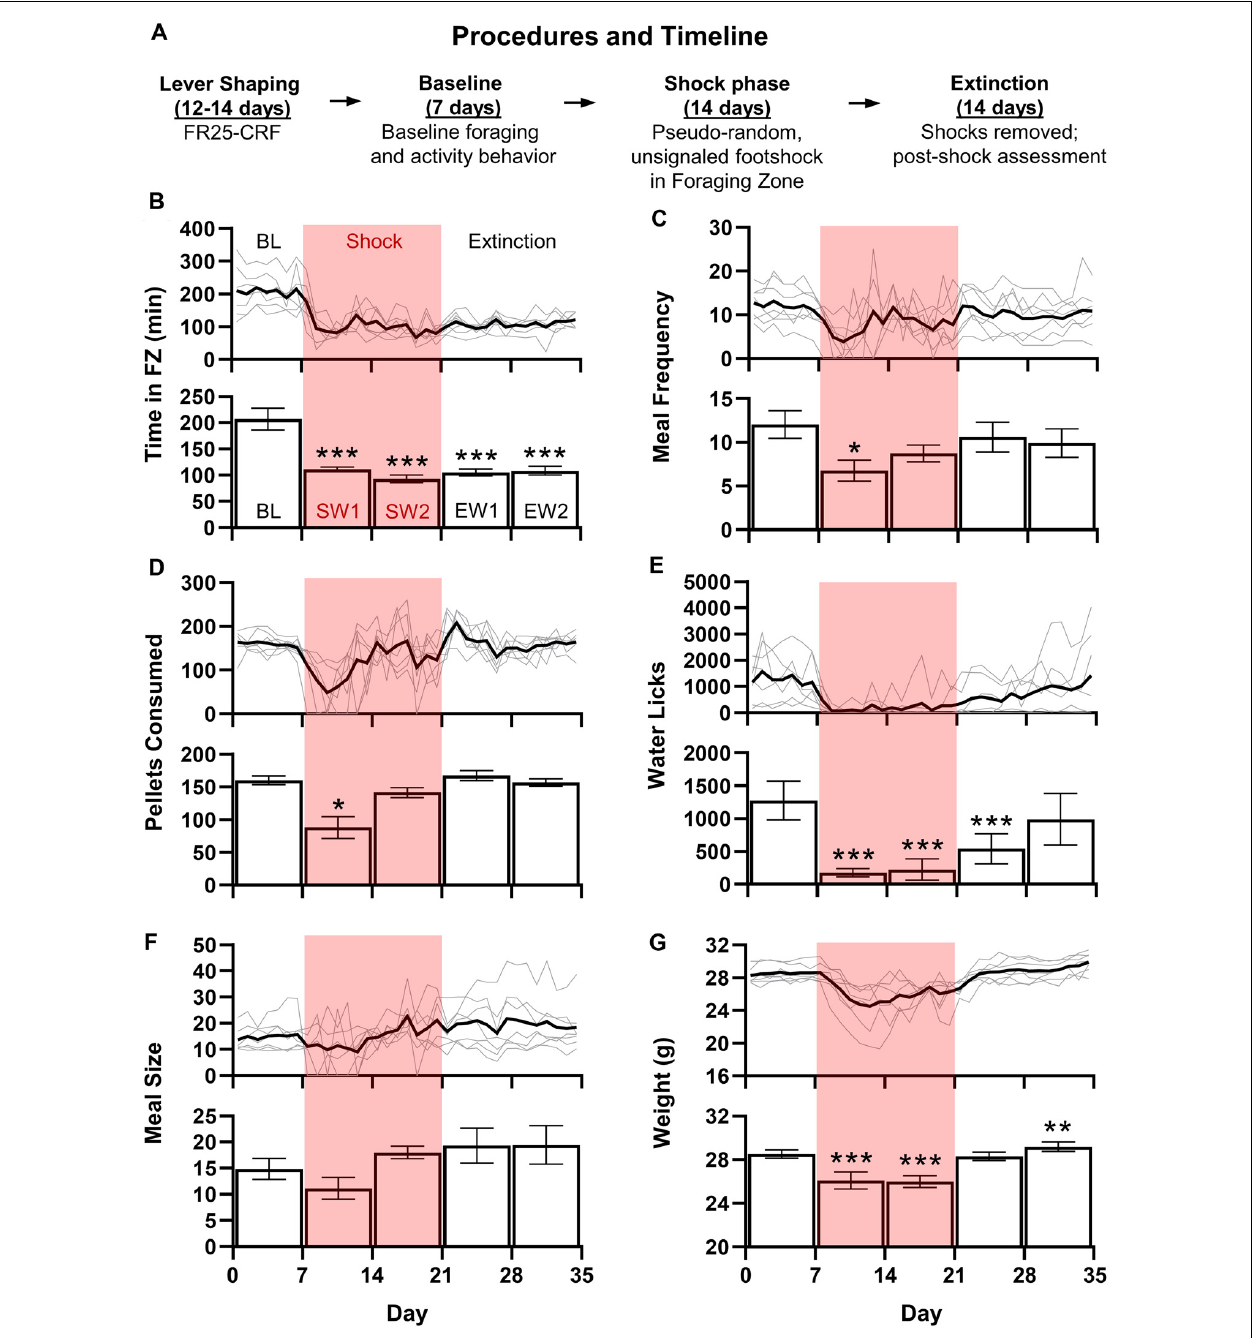
FIGURE 2 | Mice are a viable alternative to rats in RCE experiments. (A) Upon arrival, animals were immediately housed in RCE Chambers distributed between two rooms (four chambers/room). Mice were then shaped to lever press for food at a fixed ratio 25-continuous chained schedule of reinforcement (FR25-CRF), wherein each press beginning at FR25 results in one pellet/press. The schedule resets after 1 min of lever inactivity. A “meal” occurs when the FR threshold is met and continues until the scheduled reset. Shaping begins at FR1 and doubles every 2 days until FR25 (except FR16 transitions to FR25). Baseline foraging and activity level assessment follow until 7 days of stable behavior are obtained. Unsignaled, pseudo-random ( ∼ 2/h) footshocks (0.5 mA, 10 s or until escape to Nest Zone; 48 shocks/day max) are introduced in the Foraging Zone for a 2-week Shock phase. Finally, shocks are terminated for a 2-week Extinction phase. (B–G) shows the daily average (black line) with individual mouse data (gray lines; top) and weekly average ± SEM (bottom) for daily total time spent (minutes) in the Foraging Zone (B) , meal frequency (or the number of meals/day; C ), food pellets consumed (D) , water lick meter beam breaks (E) , meal size (food pellets/meal; F ), and animal weight (grams; G ) of adult male C57BL/6 mice (3 months old upon arrival; N = 7) across Baseline (BL), Shock (S) and Extinction (E) phases (* p < 0.05, ** p < 0.01, *** p < 0.0001 vs. Baseline).